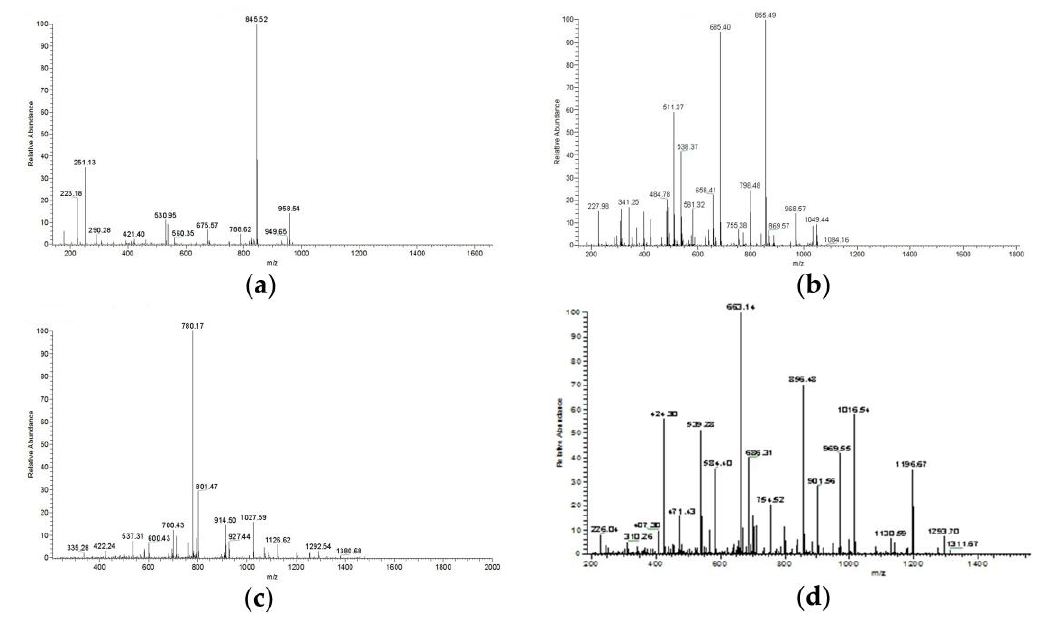
Figure3. TwolevelmassspectrometryoftheZihuasnapbeanlectin( a )HIGIDVNSIK,( b )GGLLGLFNNYK, ( c ) GENAEVLITYDSSTK, and ( d )